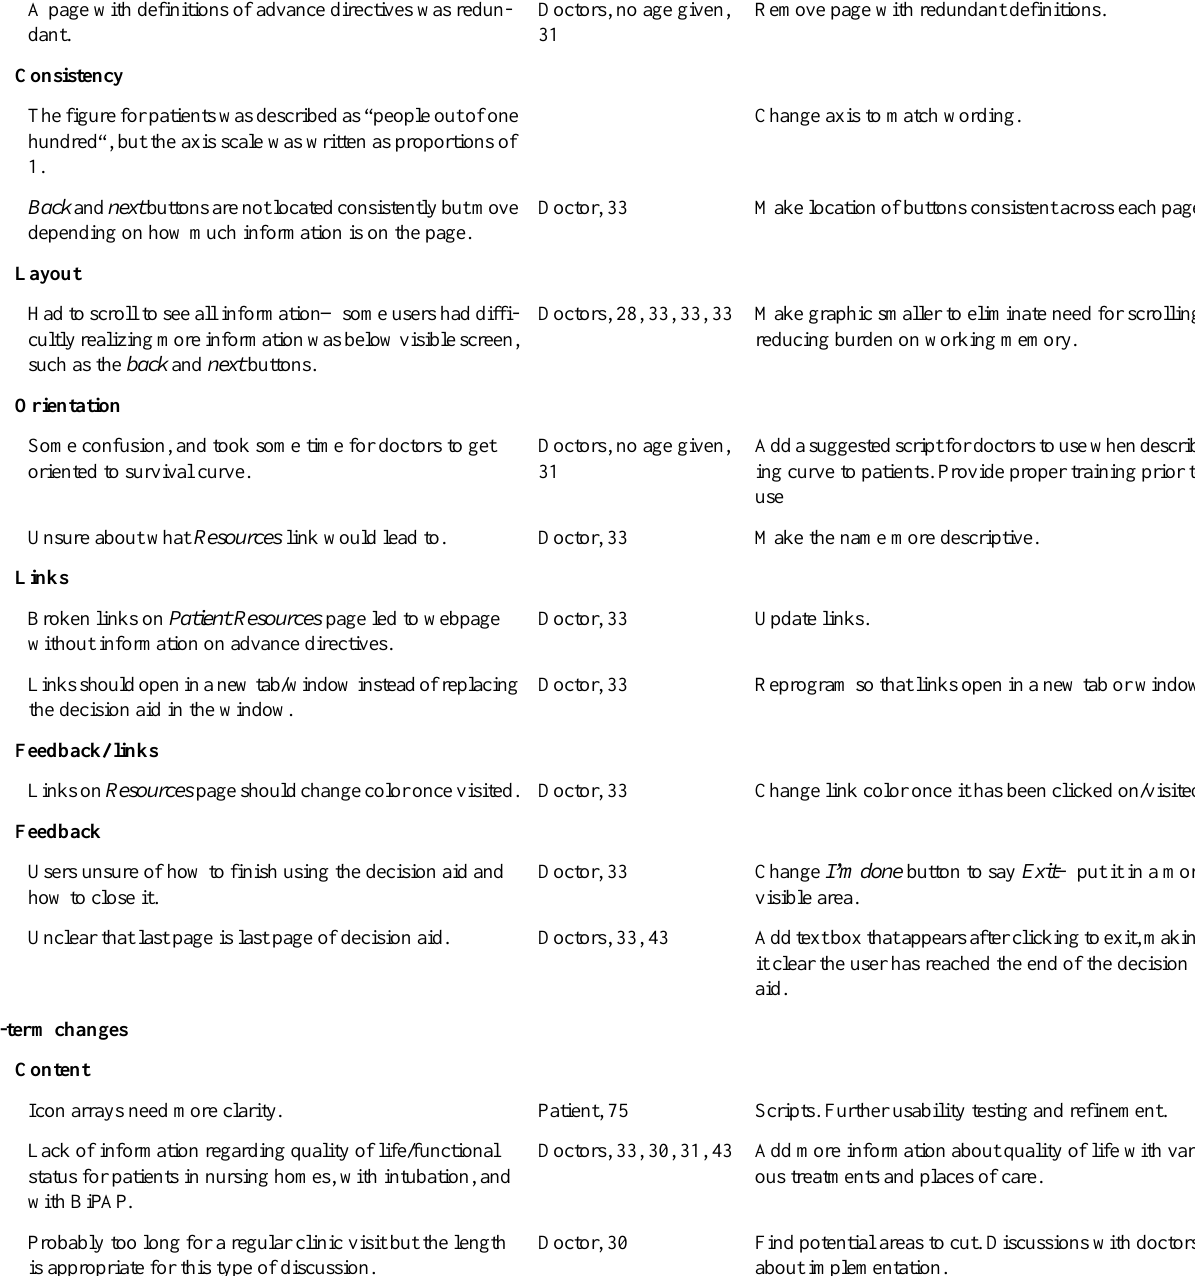
33Unclear which screens are meant to be shared with the pa- tient. tube